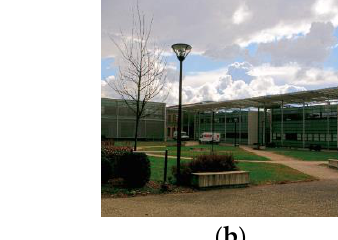
Figure 3. LIP tone mapping algorithm using LIP subtractions to enhance a color low-light image. ( a ) Original image; ( b ) LIP Tone Mapping applied on ( a ).